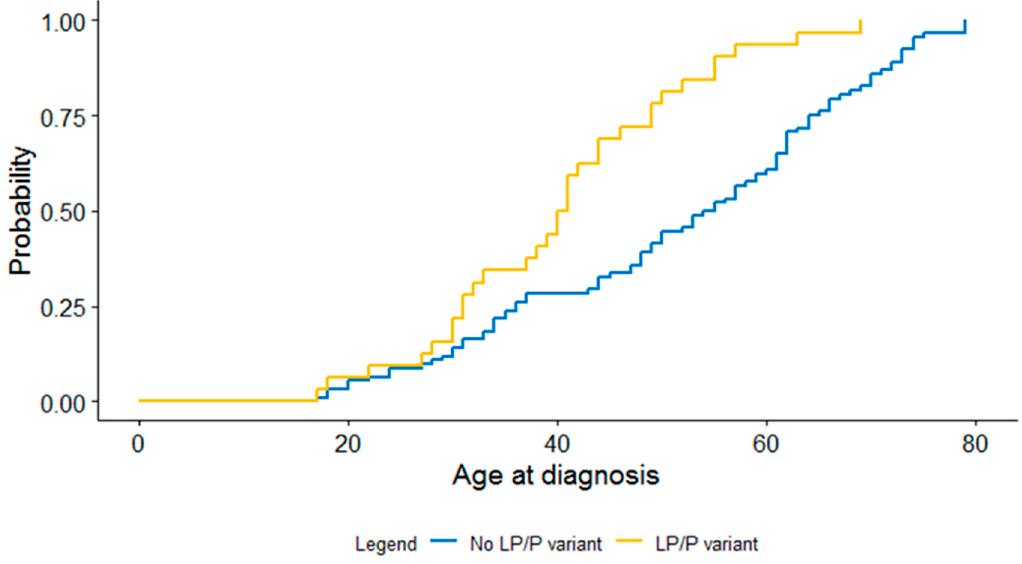
Figure 2. Kaplan–Meier curve for difference in age at diagnosis between patients with and without a LP/P variant.